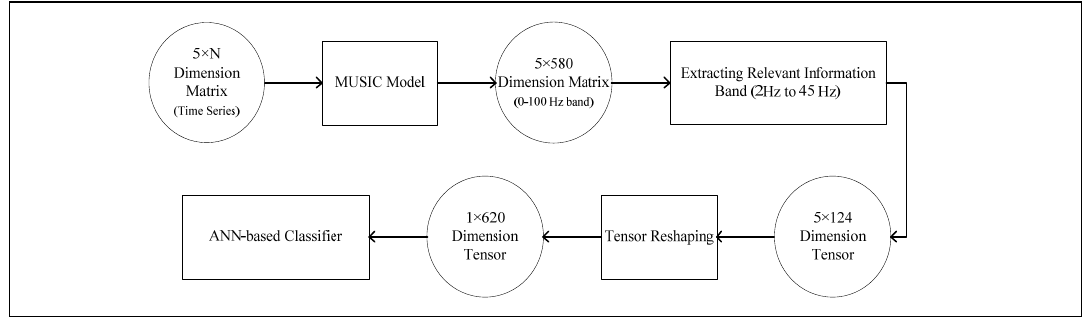
Figure 6. Flow diagram explaining feature-extraction process for 5 × 124 Tensor from reduced 5 × N dimension trials.